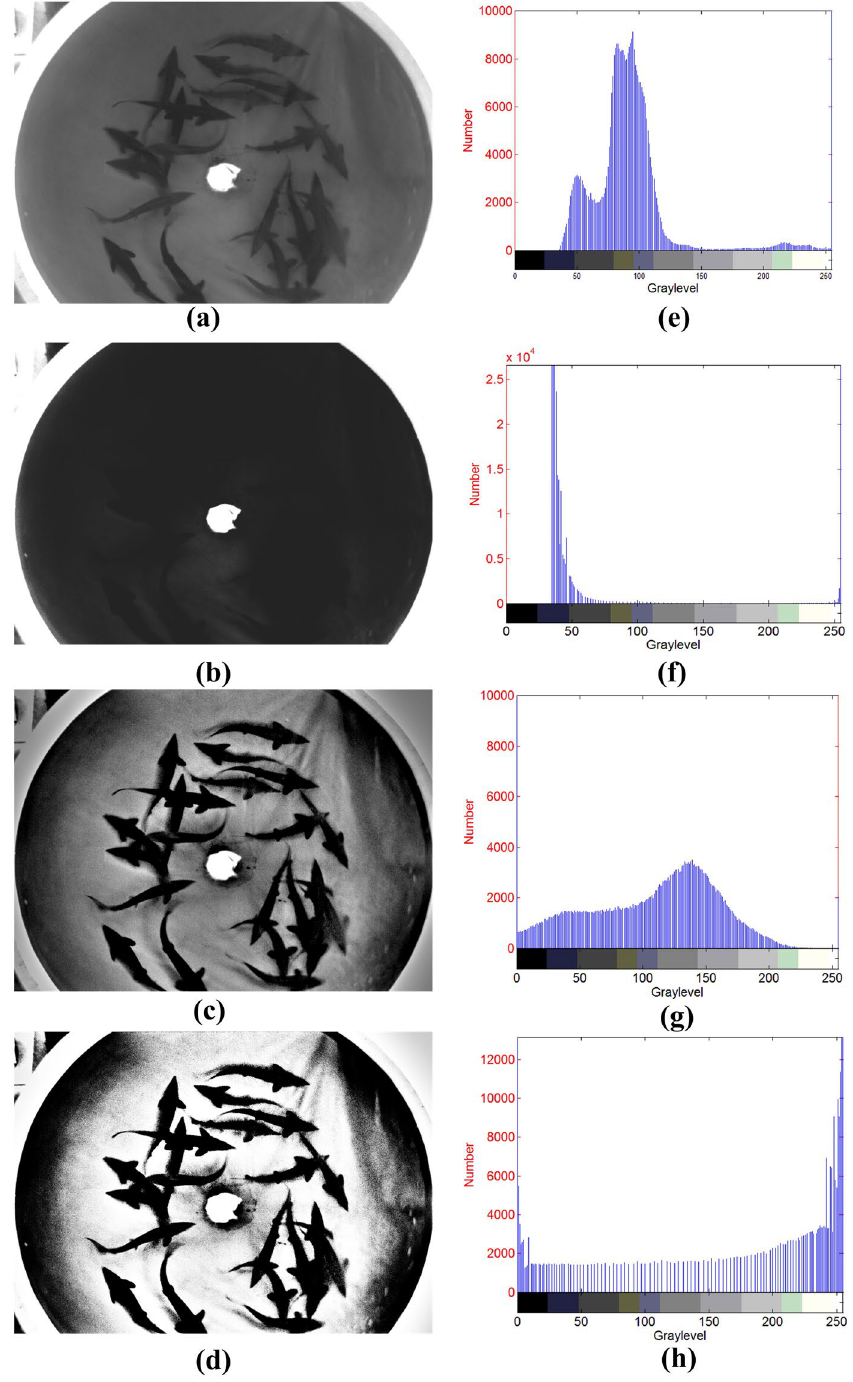
Figure 3. Image enhancement effect: ( a ) original image; ( b ) nonlinear transformation of Fig. 3a; ( c ) the original image enhanced by the MSR algorithm; ( d ) proposed method; ( e ) histogram of Fig. 3a; ( f ) histogram of Fig. 3b; ( g ) histogram of Fig. 3c;( h ) histogram of Fig.